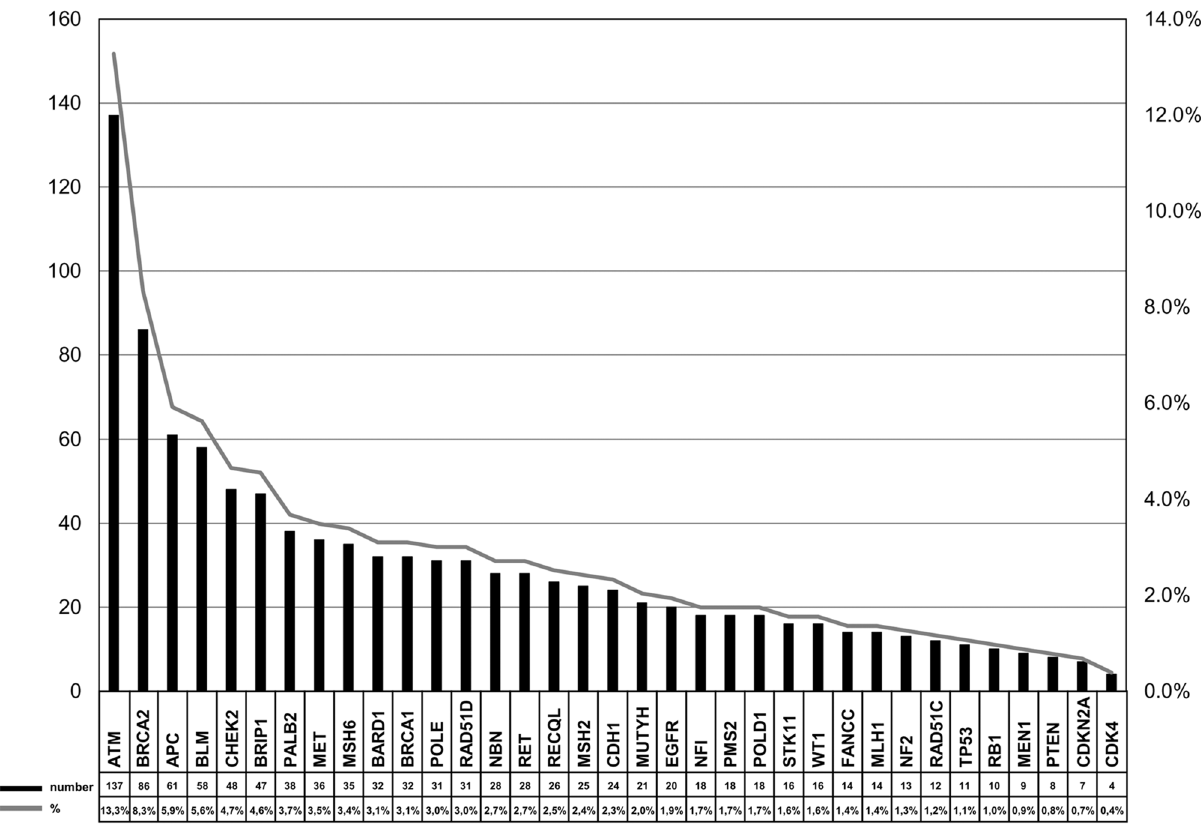
Figure 4. Number and percentage of variants of unknown significance per